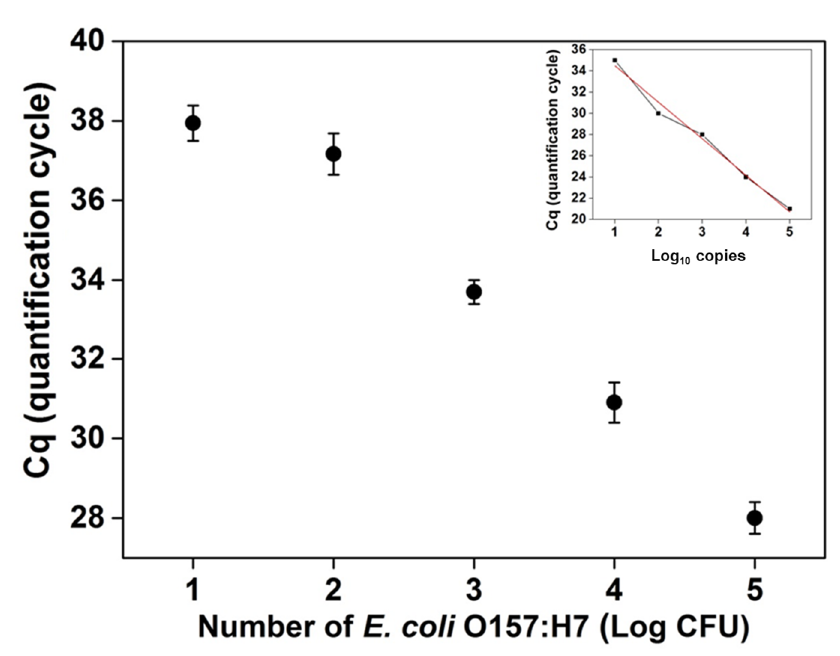
Figure 2. Standard curves for heat-killed E. coli O157:H7 and for eluted genomic DNA (inset). The curves display a linear correlation between quantification cycle (Cq) and the quantity of cell lysate or dilution factor of genomic DNA.